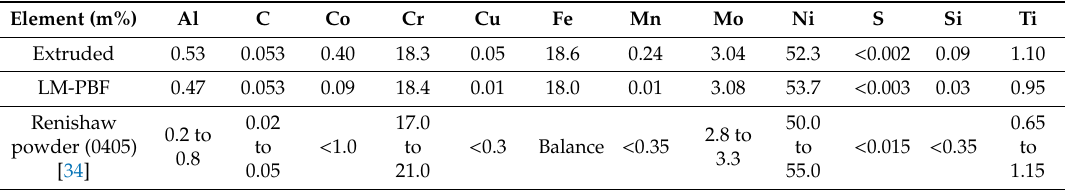
Table 3. Chemical composition of the INCONEL718 (IN718) extruded tube, LM-PBF sample, and Renishaw IN718 powder specification [34].